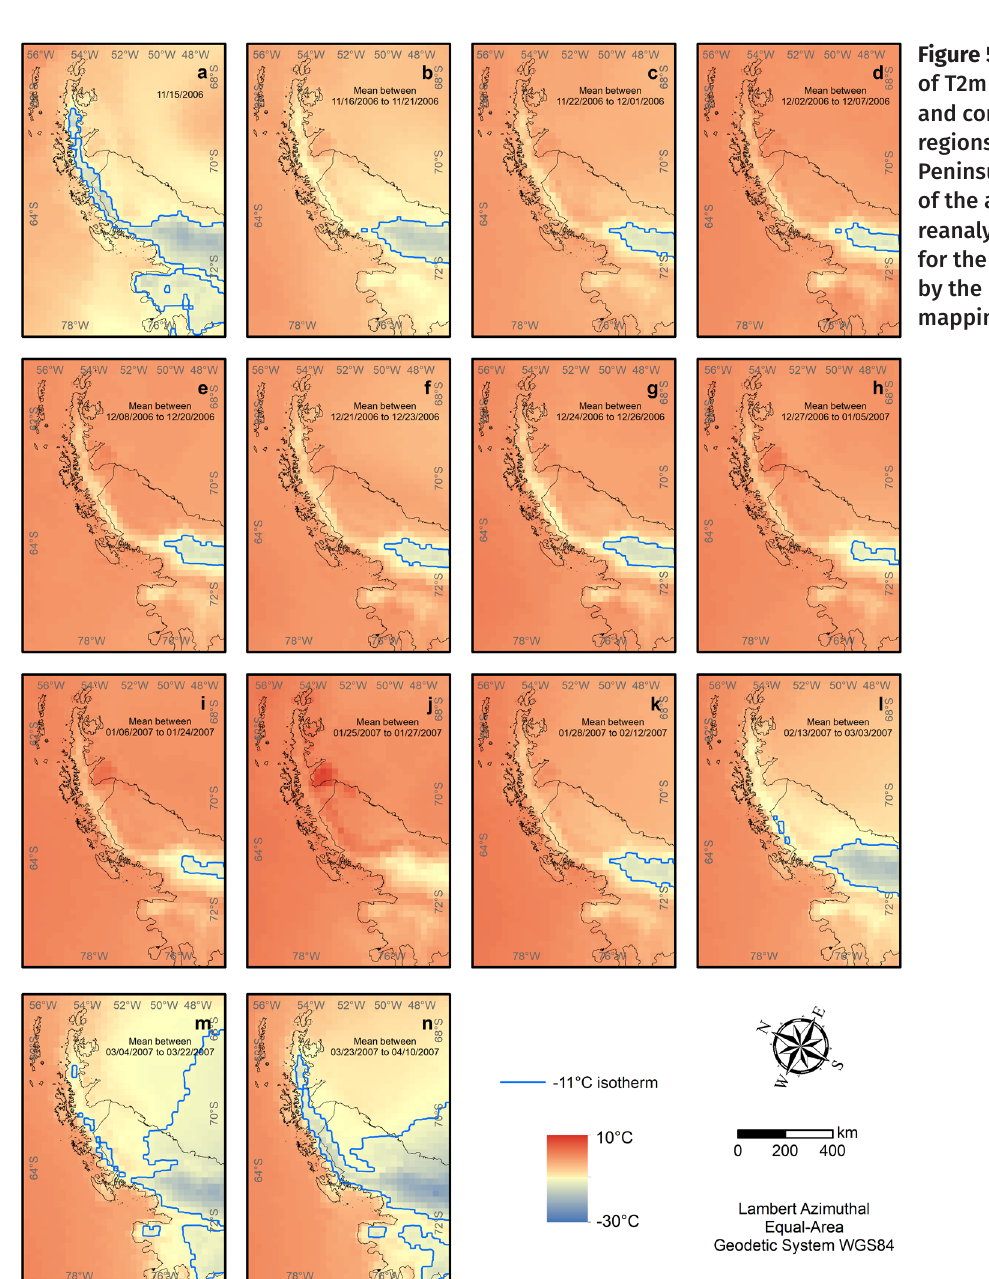
Figure 5. Spatialization of T2m in the oceanic and continental regions of the Antarctic Peninsula, obtained of the atmospheric reanalysis model ERA5, for the period covered by the radar glacier zone